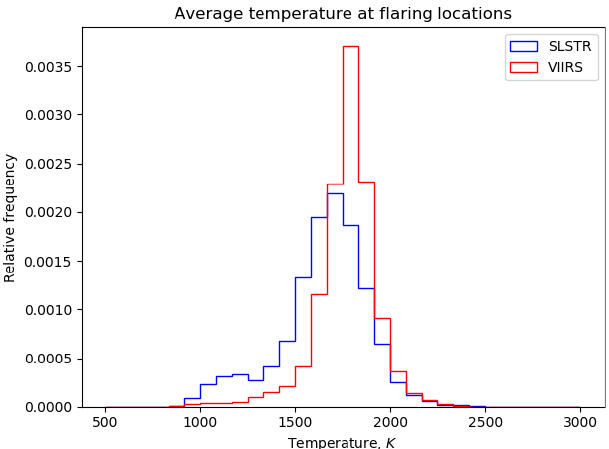
Figure 21. Comparison of the average retrieved temperature at the flaring locations for VIIRS Nightfire (locations shown in Fig. 16 in red) and for SLSTR (locations shown in Fig. 4 in blue). Relative frequency is used to ensure comparability independently of the to- tal number of observations (6232 flaring locations for SLSTR and 10185 flaring locations for VIIRS Nightfire).